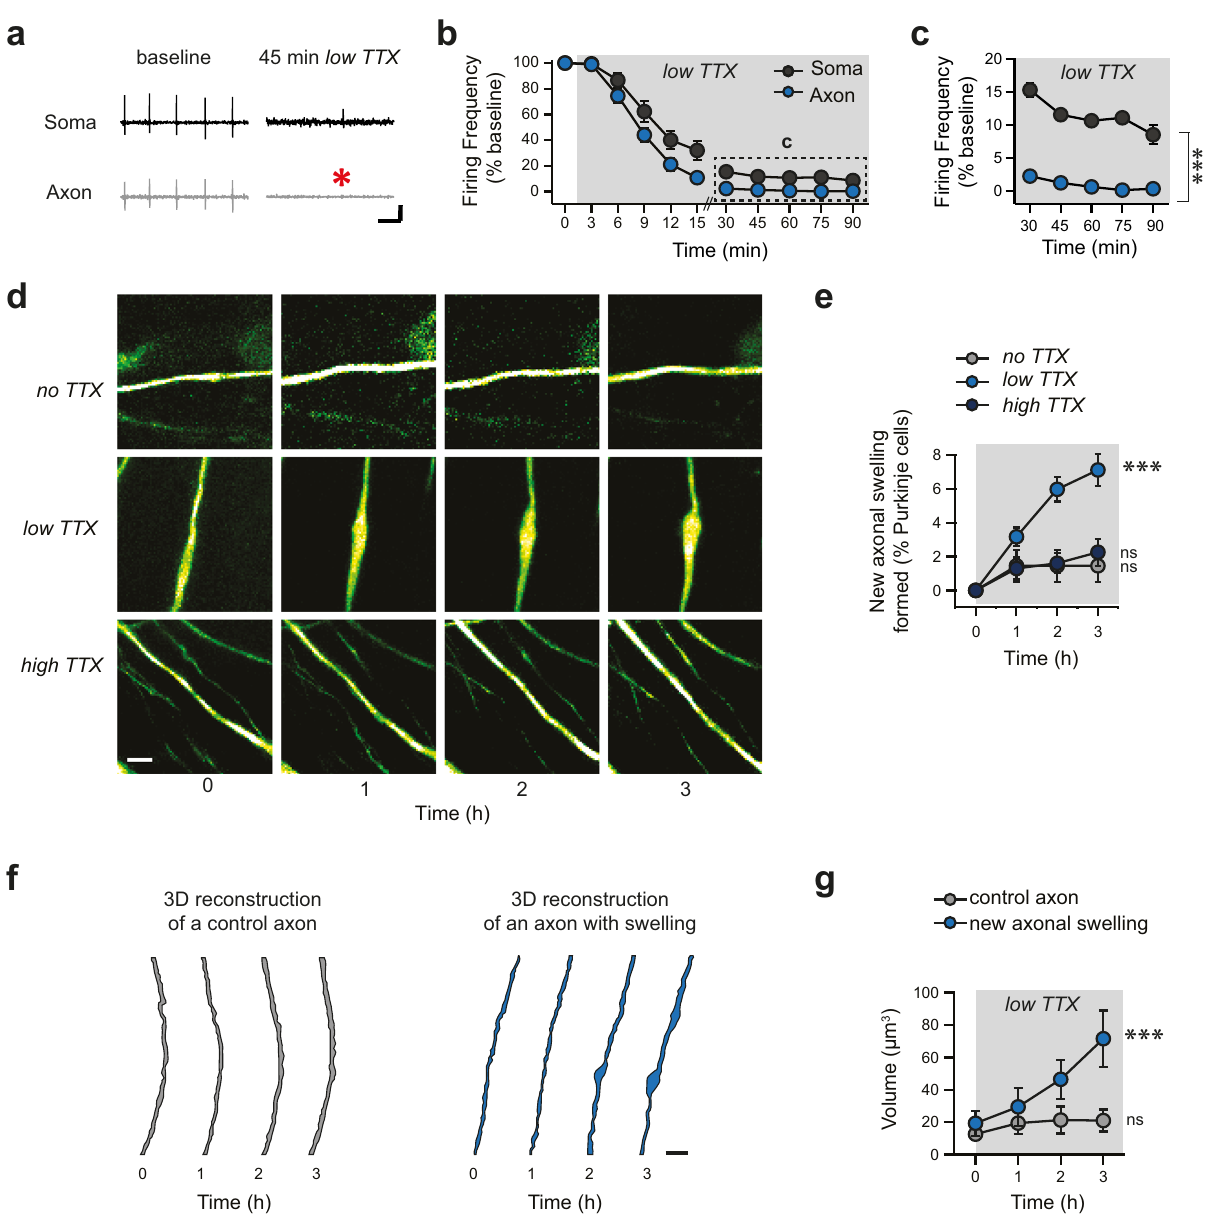
Fig. 4 Enhancing axonal failures causes axonal swellings to form. a Sample recordings from Purkinje cell soma (top, black) and axon (bottom, gray) prior to (left) and 45 min after (right) low TTX has been applied onto an acute cerebellar slice. Action potential amplitudes are reduced and axonal failures become prominent. Red asterisk indicates action potential failures in the axon. Scale bar, 1 mV, 25 ms. b Summary data showing that fi ring in Purkinje cell axons is reduced to a greater extent than in the soma, mimicking axonal failures. In some cases, axons and soma recordings were not from the same cell. Frequency was normalized to initial frequency prior to TTX wash-in in order to compare these cases ( n = 17 simultaneous somatic and axonal recordings from N = 15 mice). c Replotting data in panel ( b ) showing expanded y-axis. Axonal fi ring rates are signi fi cantly lower than somatic fi ring rates, indicating that more failures occur in the axon and that this persists throughout the recording ( n = 12 simultaneous somatic and axonal recordings from N = 11 mice at the last data point, as some of original 17 recordings did not last full 90 min; repeat-measured ANOVA followed by pairwise comparisons two-tailed Student ’ s t- test using Bonferroni correction shows signi fi cant difference at each timepoint, P < 0.001). d Representative images of axons at 1-h intervals after bath application of regular ACSF (no TTX, top); low TTX (10 nM), and high TTX (200 nM). Scale bar, 5 μ m. e Low TTX treatment results in the formation of new axonal swellings (no TTX, n = 6; low TTX, n = 38; high TTX, n = 6; repeated measures ANOVA showed a signi fi cant difference over time for low TTX but not the other conditions, P < 0.001). f 3D reconstruction of new axonal swelling (right) and neighboring axons without the formation of swellings (left) demonstrate that axons that later produce swellings are not morphologically distinct at the initial timepoint (time 0). Scale bar, 5 μ m. g Summary data from 3D reconstructions reveals that volume of axons with swellings differs after 3 h, but is not different from control axons at time 0 (control axon, n = 8; new axonal swelling, n = 8; repeated measures ANOVA; P < 0.005). Data were presented as mean ± SEM (*** P < 0.005; ns P > 0.05). Source data are provided as a Source Data fi